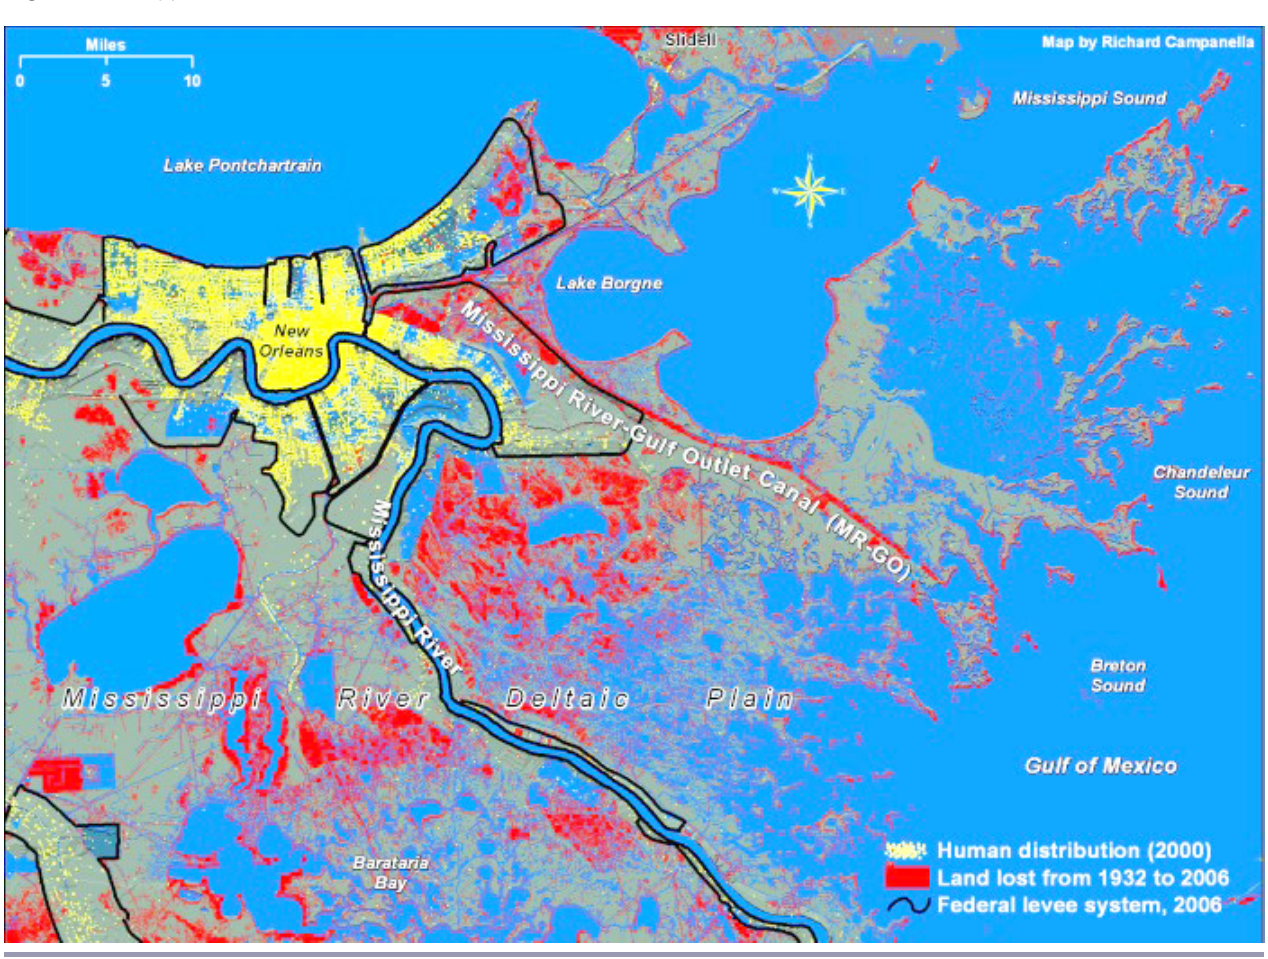
Fig. 2 . Mississippi River-Gulf Outlet